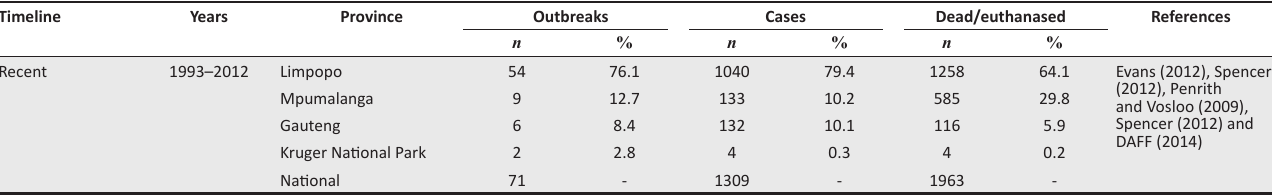
TABLE 1: Reported outbreaks of ASF, 1993–2012 in South Africa. Timeline Years Province